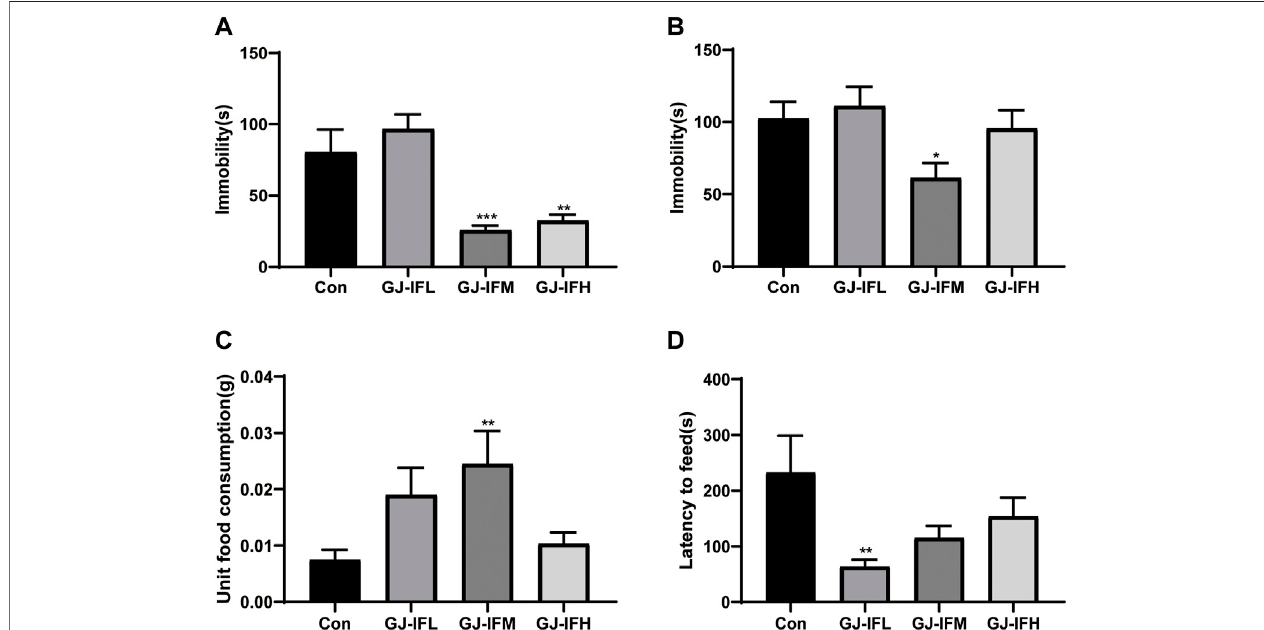
FIGURE4| Screenforoptimal dosageofGJ-IFwithrapidantidepressantpotential.Thelow,medium,and highdosesofGJ-IFareabbreviatedasGJ-IFL,GJ-IFM, GJ-IFH. (A) Tailsuspensiontestat1 dafteradministrationofGJ-IF.Immobilitytimewasmeasuredforthelast4 minduringthe6mintestingtime.One-wayANOVA,** p < 0.001, *** p < 0.001; control vs. GJ-IF. (B) Forced swim test at 1 d after administration of three doses of GJ-IF. One-way ANOVA, * p < 0.05; control vs . GJ-IF. (C) Unit food consumption during 10 min test of novelty suppressed-feeding at 1 d after administration of three doses of GJ-IF. One-way ANOVA, ** p < 0.01; control vs